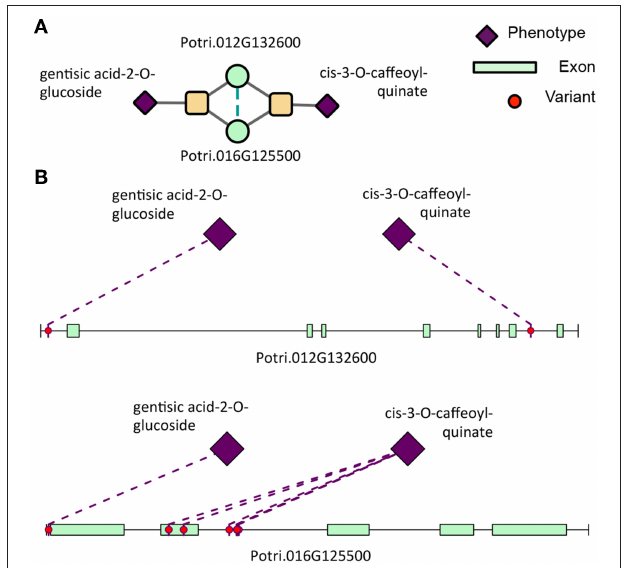
FIGURE 12 | Type 2 signature cluster. (A) Signature cluster defined by a Type 2 association with gentisic acid-2-O-glucoside and cis-3-O-caffeoyl-quinate. (B) Associating SNP positions within genes in this signature cluster. These SNP associations have negative effect sizes (beta values) on the phenotype values. See Table 1 for gene information.